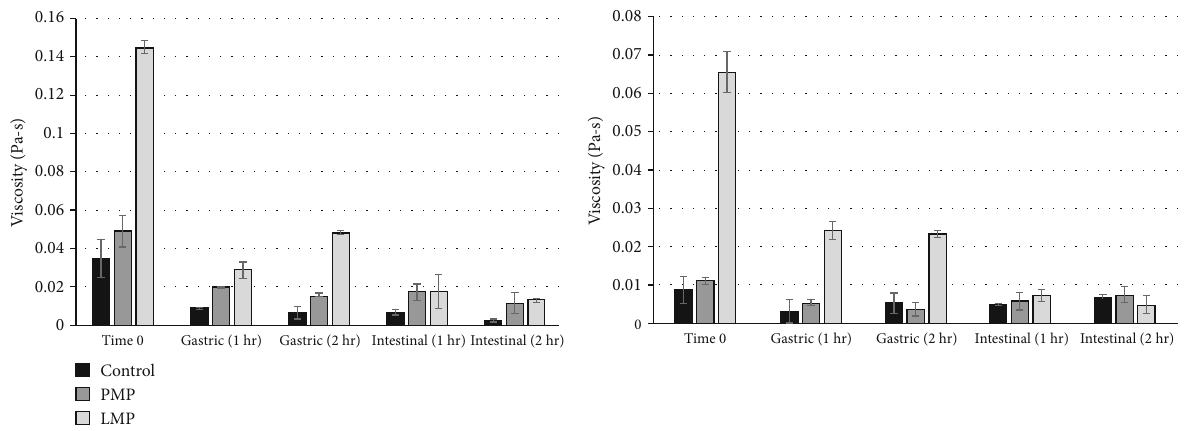
Figure 5: In vitro digestion viscosity of pectin (2%) — forti fi ed orange juice at physiologically relevant shear rates (left: ~ 10s -1 , right: ~ 50s -1 ). Data are mean + standard deviation of three